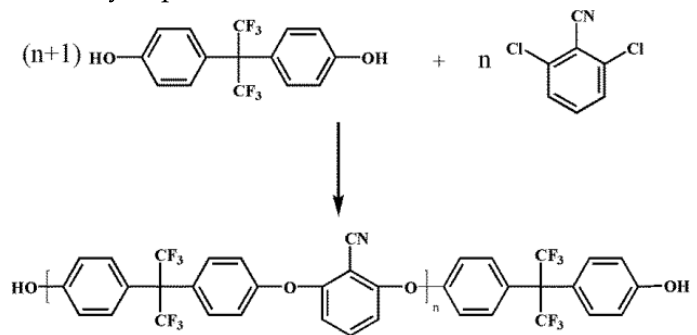
Figure 1. Synthetic route of hydroxyl terminated poly(arylene ether nitrile) (PEN-OH).